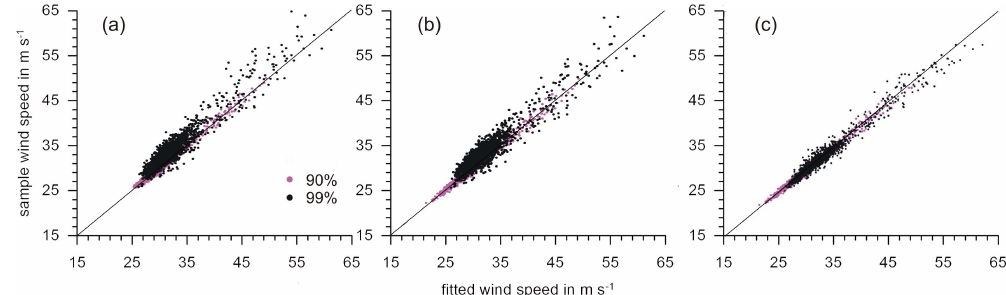
Fig. 2. Quantile-quantile plots showing the fit of three theoretical distributions to the 90th and 99th percentiles of wind speed data from REMO for each grid point in the federal state of Baden-W¨urttemberg. Each point represents the data from the sample on the ordinate and the corresponding theoretical estimate on the abscissa from the gamma (a) , exponential (b) , and generalized Pareto (c) distributions.